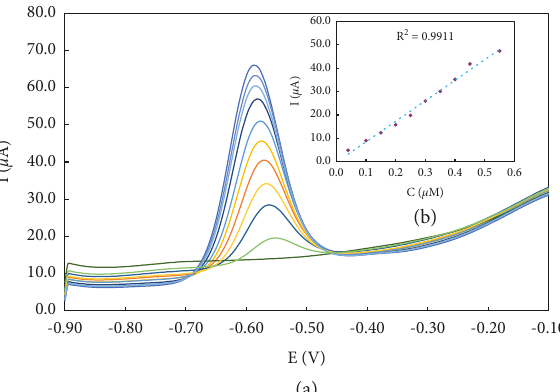
Figure 8: (a) SWV response of the modified GCE at a diverse concentration of DOX; (b) the inset plot shows the calibration curve of the process.